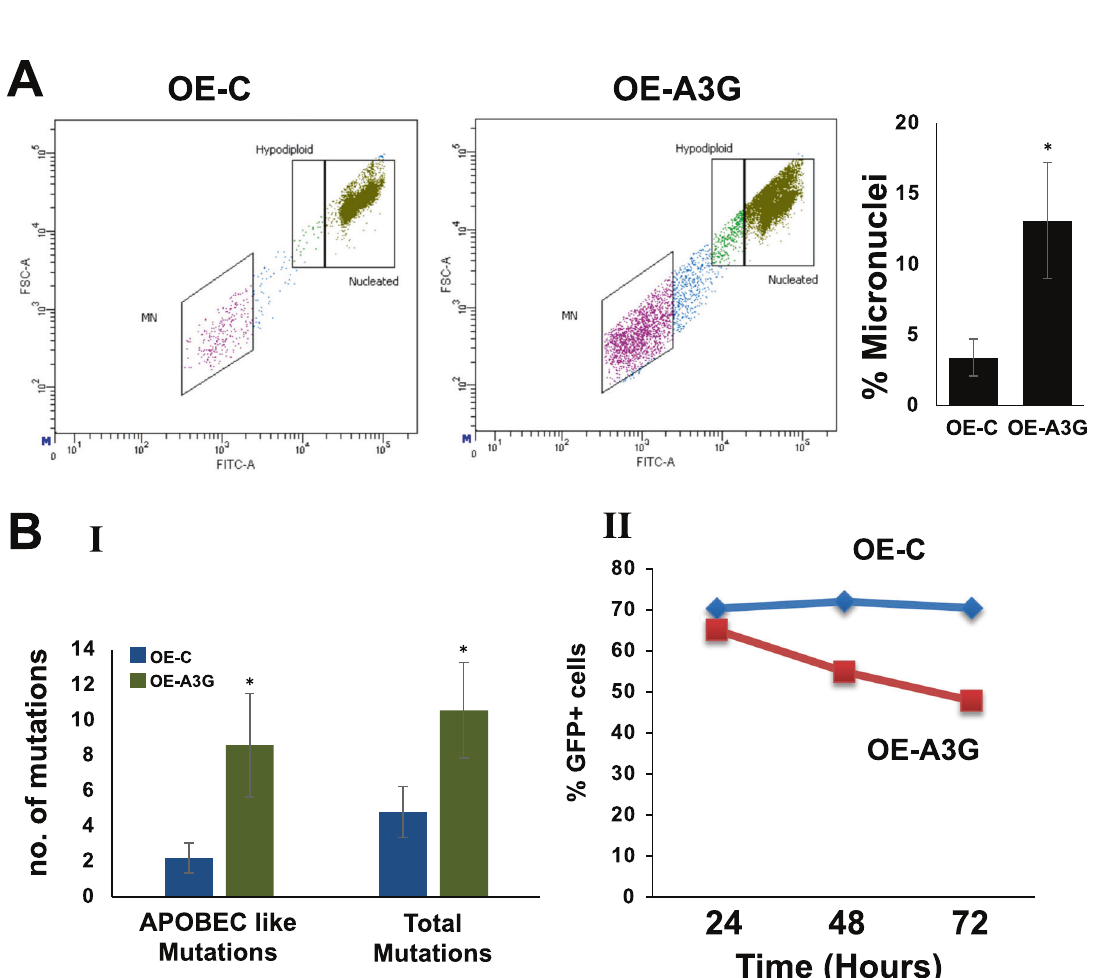
Fig. 5 APOBEC3G overexpression induces genomic instability in myeloma cells. Control and A3G-overexpressing U266 cells (described in Fig. 4) were evaluated for genomic instability. A Following selection, the cells were evaluated for the presence of micronuclei, using In Vitro MicroFlow Kit (Litron Labs). Images of micronuclei (I) and bar graphs showing percentage of micronuclei (II) are presented. B Control and A3G- overexpressing cells described above were transfected with a plasmid expressing EGFP. EGFP-positive cells were puri fi ed, cultured for additional 72 h, genomic DNA isolated, and EGFP sequences ampli fi ed using speci fi c primers. The PCR products were cloned into a plasmid vector to transfect into competent E. coli cells and plated on LB agar. Plasmid DNA from 10 colonies/sample were isolated and sequenced to analyze for mutations. I. Bar graphs show APOBEC-like mutations as well as total (or overall) mutations; II. Percent GFP + cells were analyzed by fl ow cytometry at different time points and plotted in the